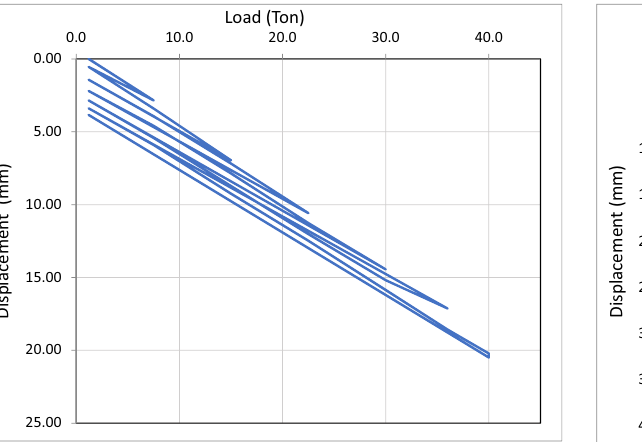
Figure 10: Load – displacement curve for anchor 3.